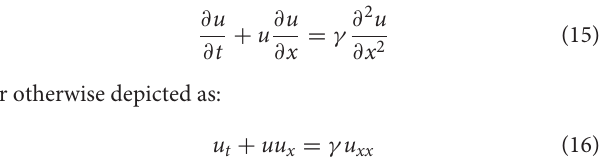
FIGURE 2 | Rarefaction-wave solution illustrating the discontinuity between incoming (horizontal) wave velocity of u ( t , x ) = v I = 1461.794m/s and outgoing velocity of u ( t , x ) = v F = 3,415m/s—where v I and v F are each taken to be constant for −∞ ≤ x ≤ 0 and 0 ≤ x ≤ ∞ , in this case, respectively. For the case of a spatially fixed-size skull there are, again, three separate intervals, whereby one writes, −∞ ≤ x ≤ 0, 0 ≤ x ≤ x R and x R ≤ x ≤ ∞ , each representing v I = 1461.794m/s, v F = 3,415m/s and then v I = 1461.794m/s again, respectively. Note, in this graph, the vertical-axis represents general (non–linear) velocity, u ( t , x ) , and the horizontal–axis generally represents distance, x